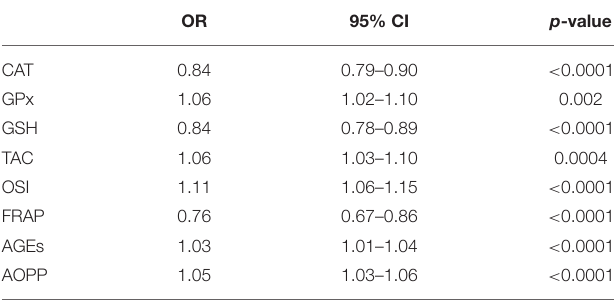
TABLE 3 | Odds ratio between schizophrenia and oxidative stress: crude results.